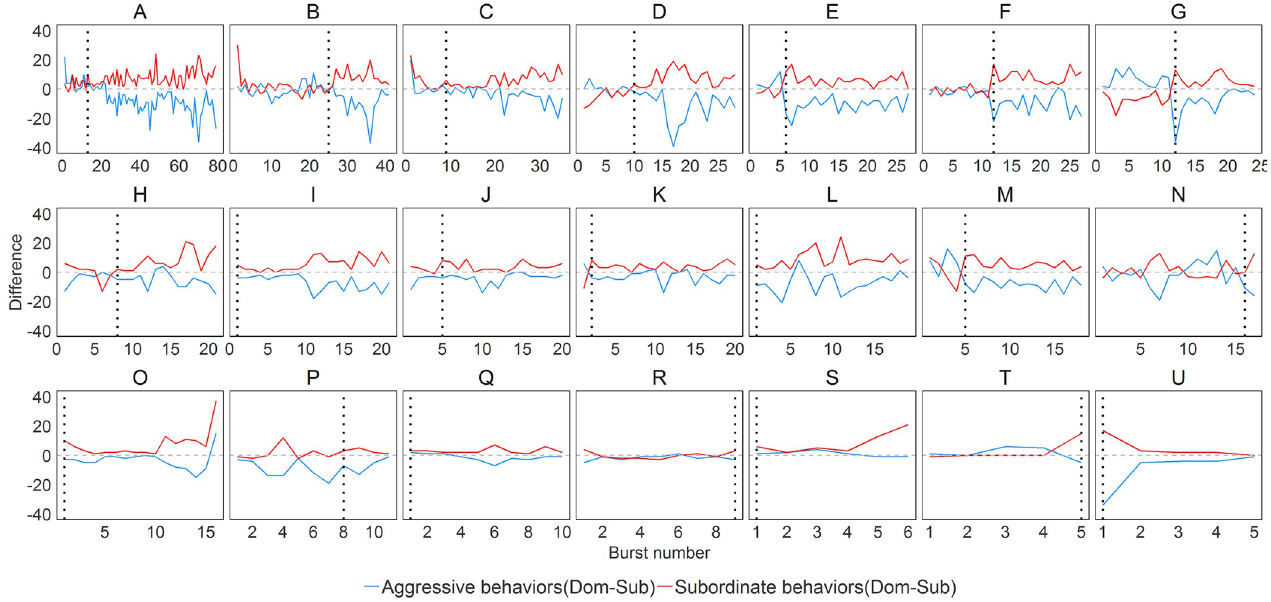
Fig 4. Differences in aggressive and subordinate behaviors between dominant and subordinate males by burst number within each dyad. The red line indicates the difference of aggressive behavior (dominant male–subordinate male) and the blue line indicate difference of subordinate behavior (dominant male–subordinate male). In difference method, the relationship is considered resolved at a point when the blue line is always below red line for all remaining bursts. Black dotted vertical lines represent when relationships are resolved according to the difference method.